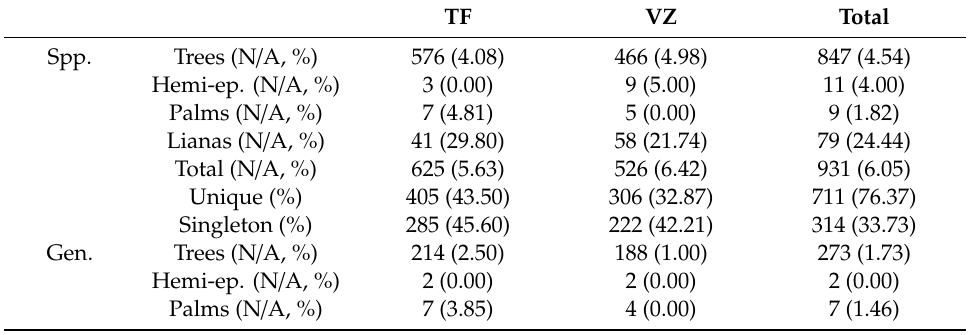
Table 2. Number of species (Spp.), number of genera (Gen.) and number of families (Fam.) found within the terra firme (TF) and v á rzea (VZ) forests along the Juru á River, western Brazilian Amazon. Values are given as counts per growth form, forest type and for both forest types combined, with percentiles of individuals not identified to each taxonomic level in parentheses (N / A, %). In addition, the numbers of Spp., Gen. and Fam. that were unique to either forest type (Unique) or occurred as singletons in either or both forest types (Singleton) are given as counts and percentiles in parenthesis (%). All values refer to trees, palms and hemi-epiphytes (hemi-ep.) with dbh ≥ 10 cm and woody lianas ≥ 5 cm dbh. TF